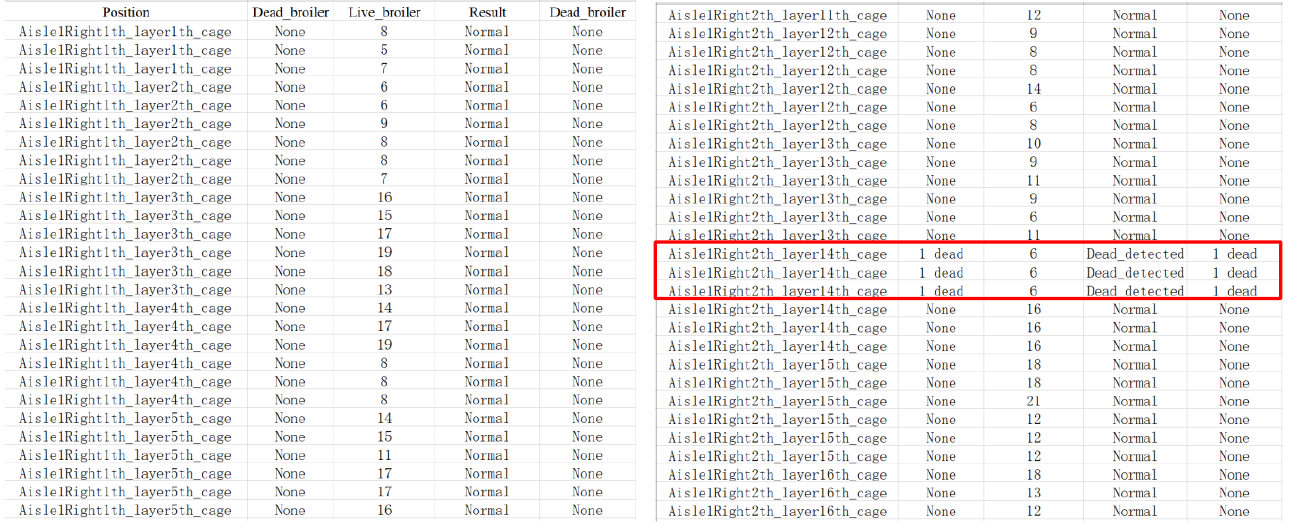
( b ) Figure 9. Test on images with different brightness. ( a ) Improved-YOLOv3. ( b ) YOLOv3 model. 3.3. Evaluation of the Dead Broiler Detection System 3.3.1. Analysis of the Detection Result of the Dead Broiler Detection System